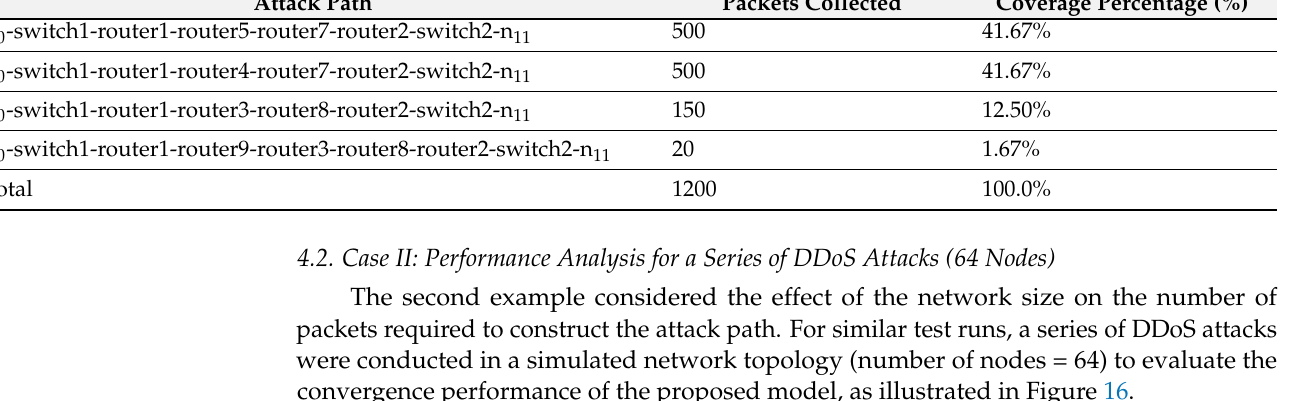
Table 5. Possible paths of DDoS attacks (number of nodes = 32, array ( x , y ), w = x). Attack